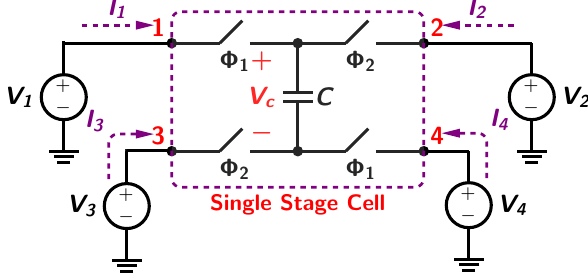
Figure 4. Single-stage DCP